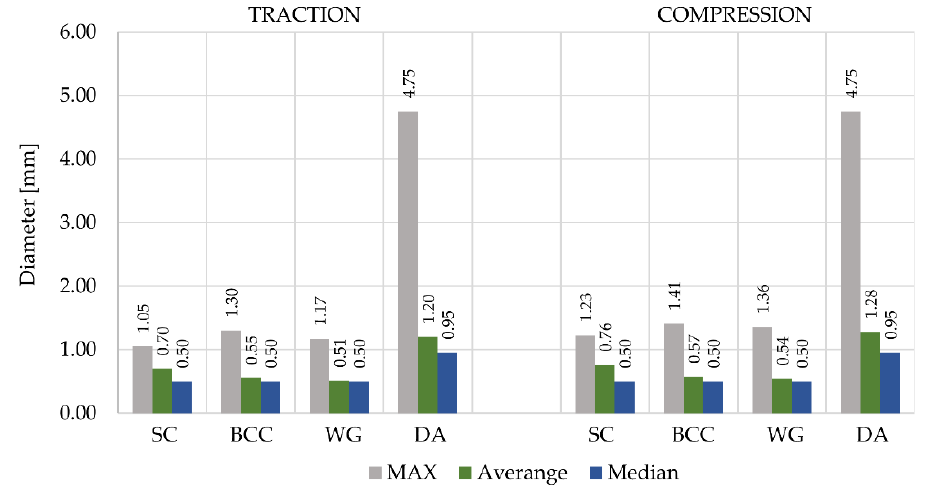
Figure 7. Overall results from the size optimization of the four lattice structures: maximum, average, and median diameter for traction and the compression load cases.